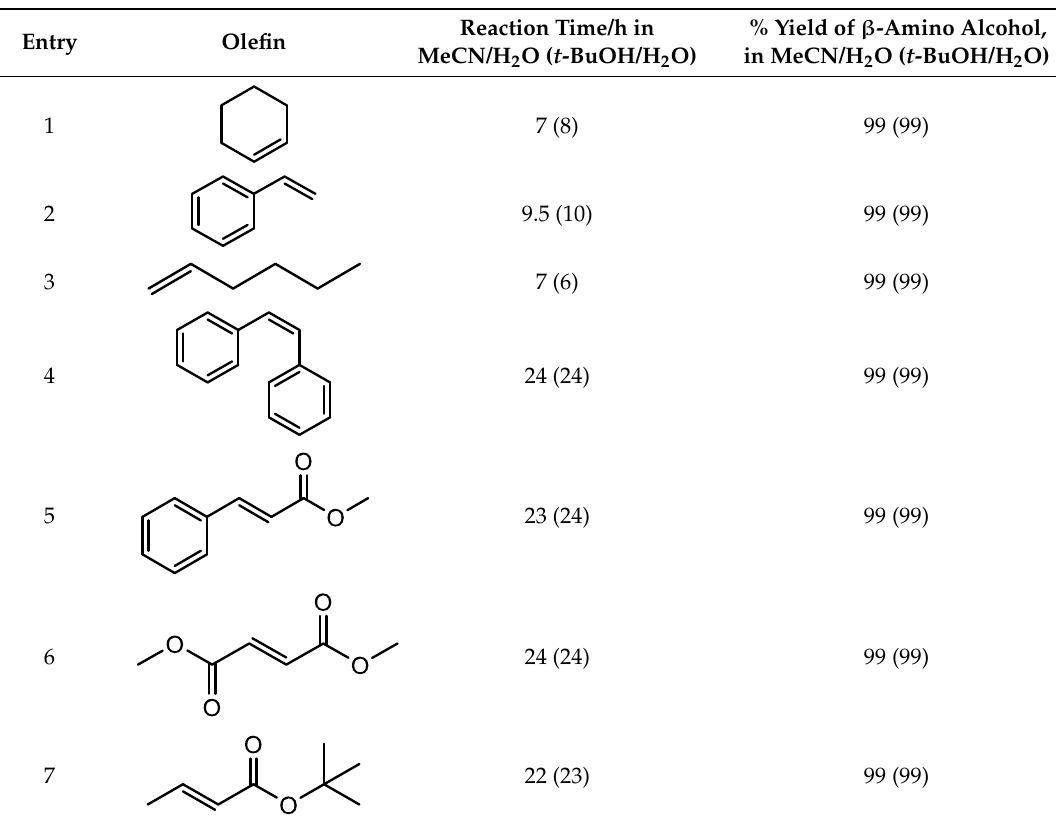
Table 2 . Reaction time and high performance liquid chromatograph (HPLC) yield percentage for the different olefins used in the aminohydroxylation reaction catalysed by the HTlc catalyst containing osmium at 25 °C.